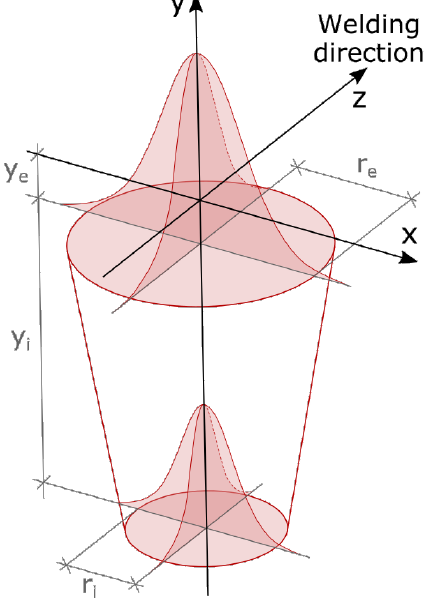
Figure 1. Conical Gaussian heat flux model.